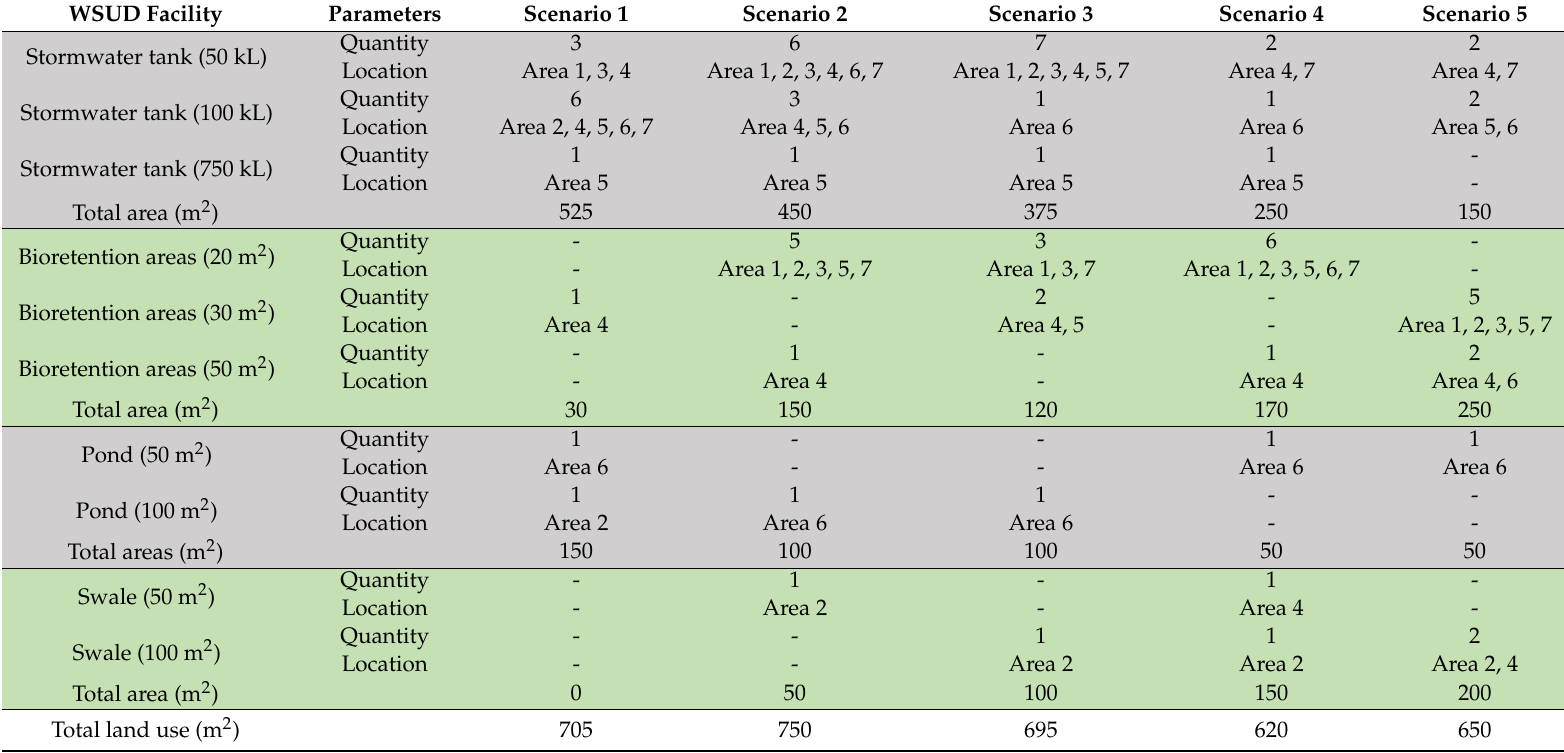
Table 6. Areas of di ff erent WSUD facilities designed five